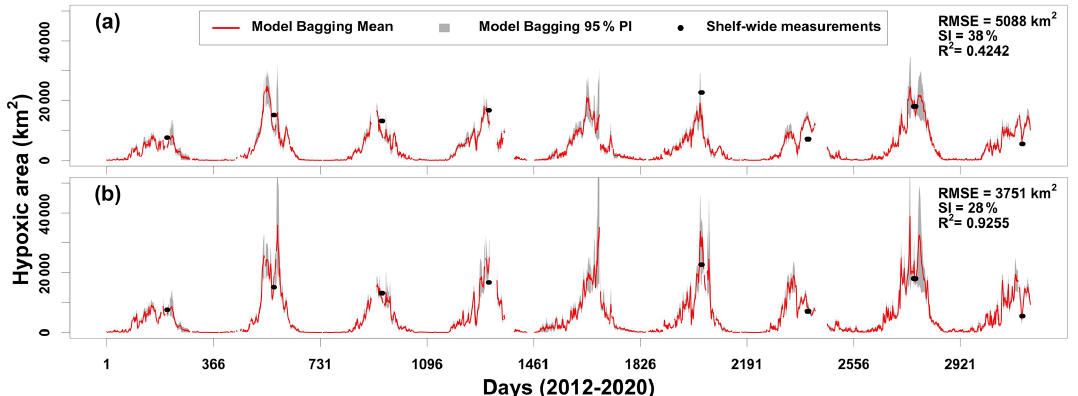
Figure 7. Comparisons of daily predicted HA by ensemble model ((GLMzip3 + GAMqsp3) / 2) when applied to adjusted HYCOM products and shelf-wide measurements from 2012 to 2020. Model results shown in (a) are predicted using pure HYCOM-derived products (i.e., PEA, SOCalt, and DCP Temp ), while those in (b) are predicted by ROMS-derived PEA, HYCOM-derived SOCalt, and HYCOM-derived DCP Temp . Discontinuity of the predictions is due to the lack of riverine nitrate + nitrite records at USGS site 07374000 in the Mississippi River.